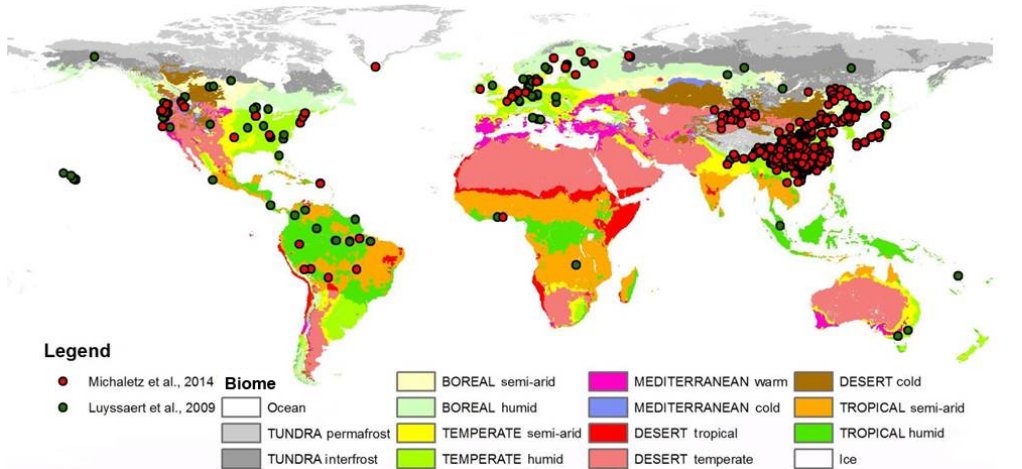
Figure A1. Map of the major biome classification based on Reich and Eswaran (2002). The red and green points are the locations of the NPP field data from Michaletz et al. (2014) and Luyssaert et al.